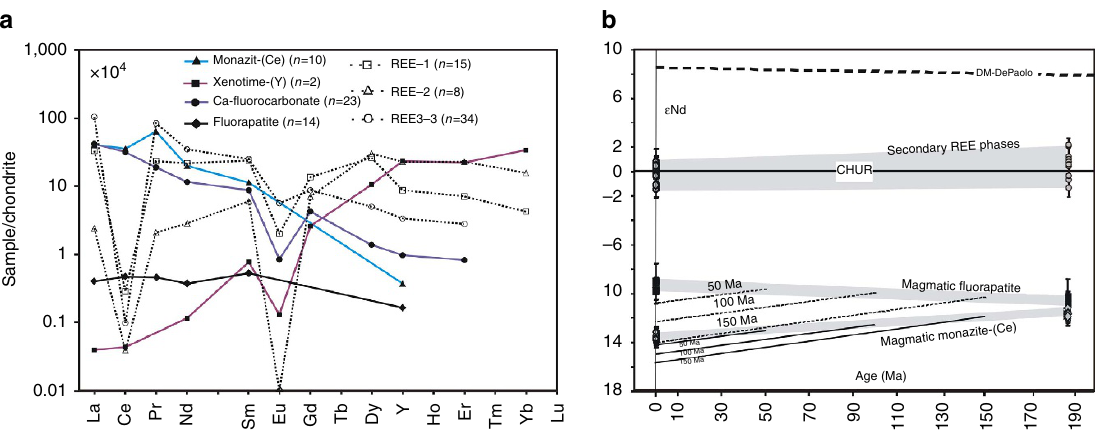
Figure 4 | Chondrite-normalized REE patterns of REE minerals and e Nd values for magmatic REE-phosphates and secondary REE minerals at the time of granite crystallization and present day. ( a ) Average REE content of REE minerals. ( b ) Neodymium isotope data indicate different REE sources in primary and secondary minerals, rather than derivation of the REE in secondary minerals via a two-stage Nd isotope evolution model 50 . The two-stage model is shown by the fine lines, and assumed the alteration of monazite-(Ce) and fluorapatite, releasing Nd to give the secondary phases. The curves show the evolution of e Nd through radiometric decay for weathering events which fractionated Sm and Nd to the elemental ratios in the secondary minerals at 150, 100 and 50Myr ago, respectively. The calculations used the decay constant and equations given by ref. 51. Release of REE from monazite-(Ce) or fluorapatite breakdown during weathering cannot explain the e Nd in secondary phases, implying that the secondary phases derived their REE from a separate, isotopically depleted, source. CHUR, chondritic uniform